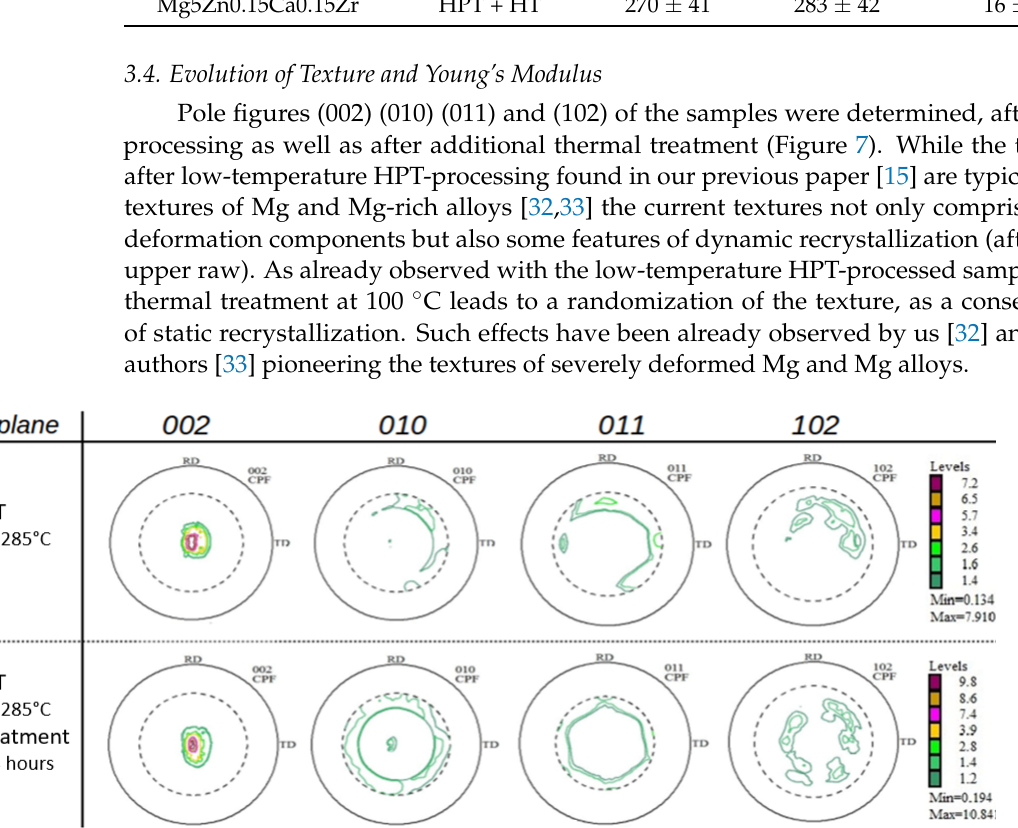
Table 4. Young’s modulus E measured by indentation microhardness of the alloys after HPT-processing by 10 rotations at 285 °C, and after additional heat treatment at 100 °C for 24 h. Simulated values E sim are given in parentheses.